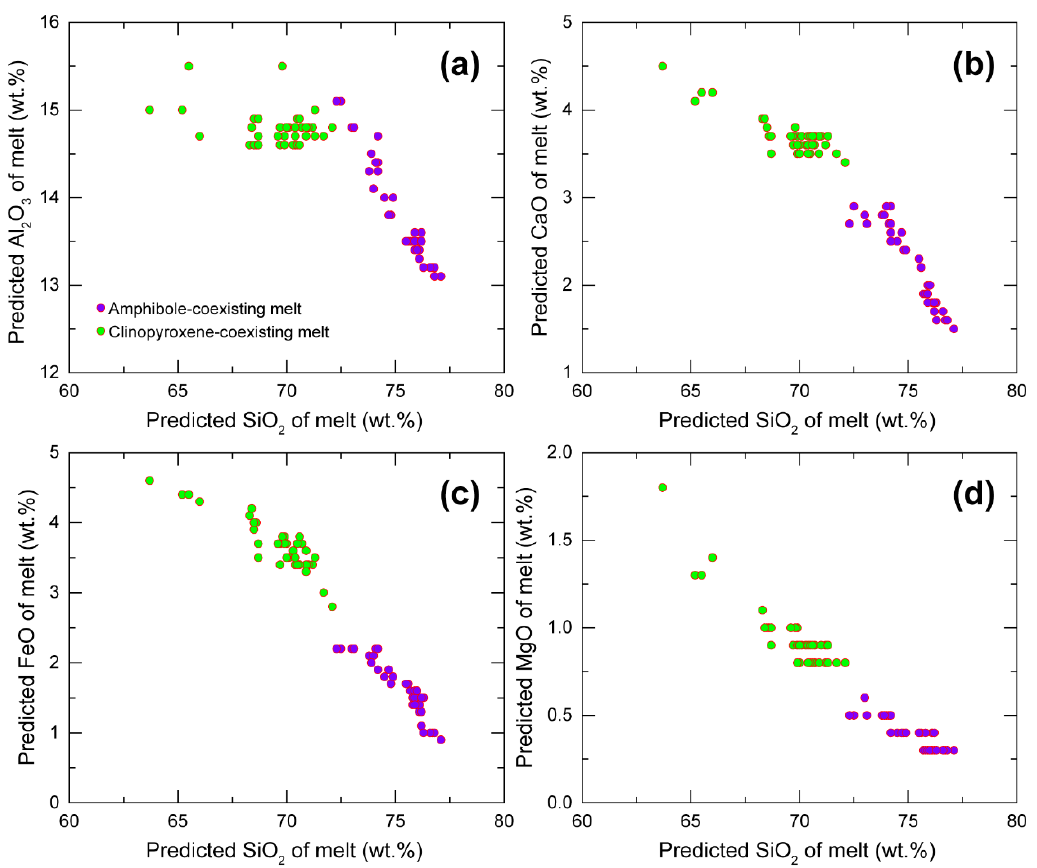
Figure 11. Al 2 O 3 vs. SiO 2 ( a ), CaO vs. SiO 2 ( b ), FeO vs. SiO 2 ( c ), and MgO vs. SiO 2 ( d ) diagrams show the estimated major compositions of amphibole- and clinopyroxene-coexisting melts [23].